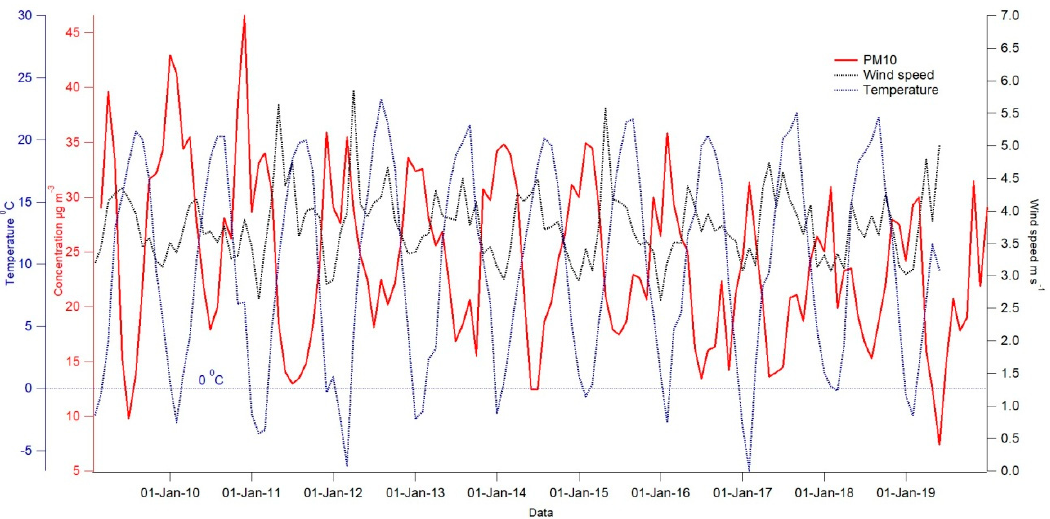
Figure 2. Temporal evolution of PM 10 , temperature and wind speed in Cluj-Napoca between 2009 and 2019.